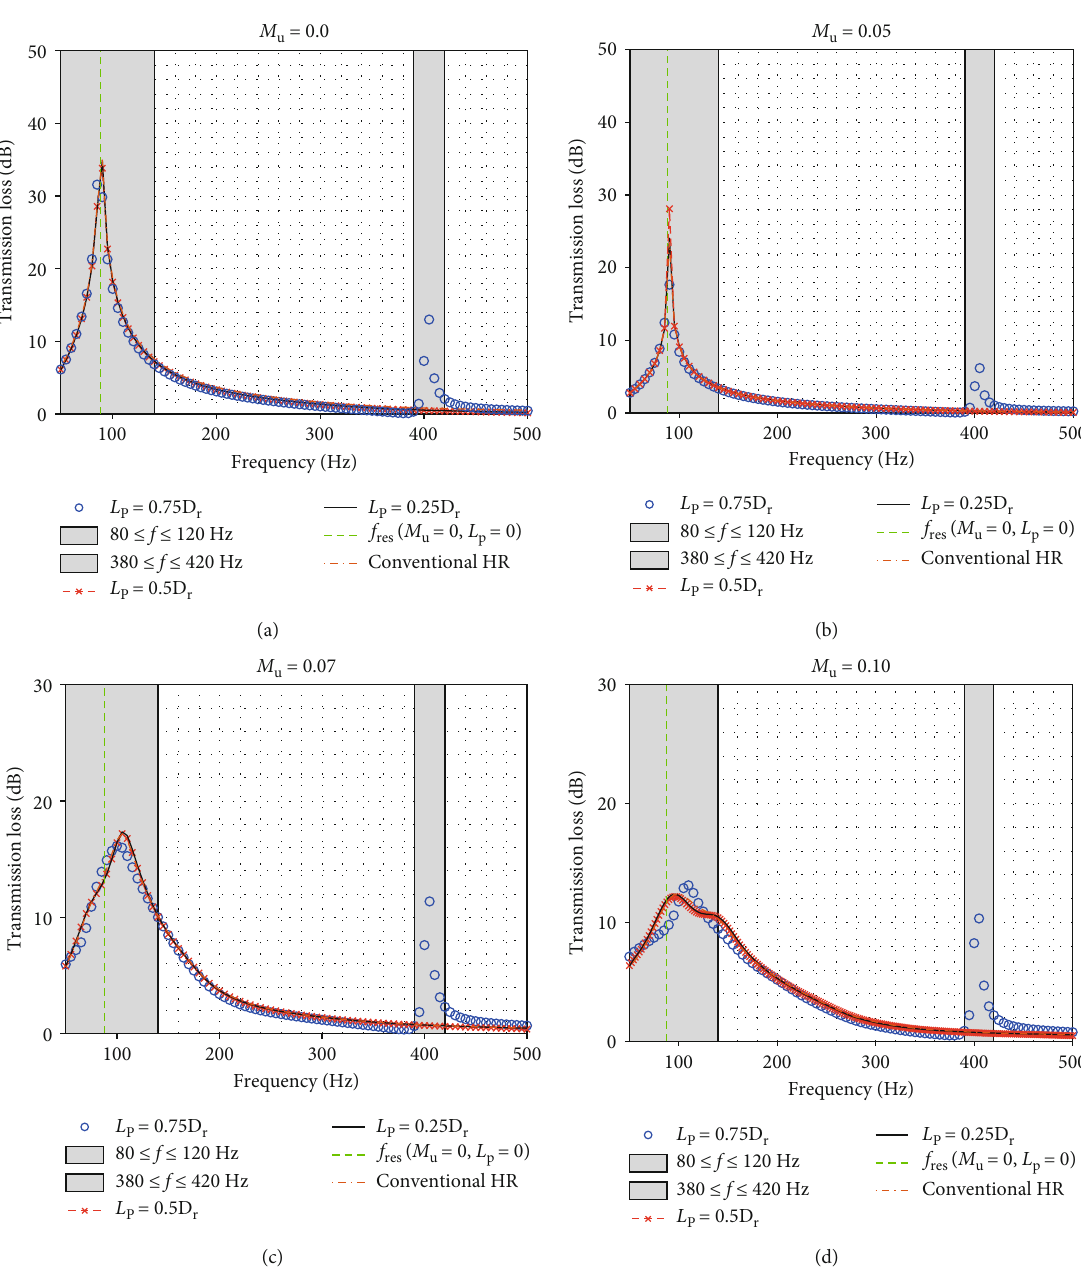
= 0 : 5 H but 3 di ff erent widths, i.e., g r = 0 : 10 u